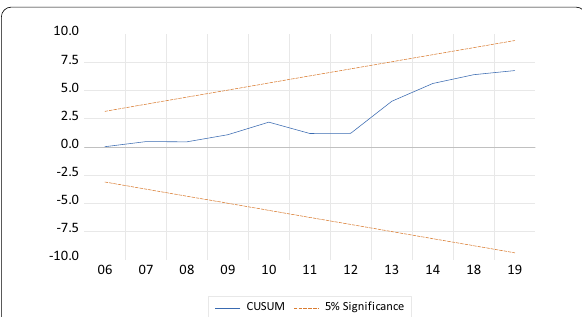
Fig. 6 Plot of cumulative sum of recursive. Source Generated by the author using Microfit 4.1